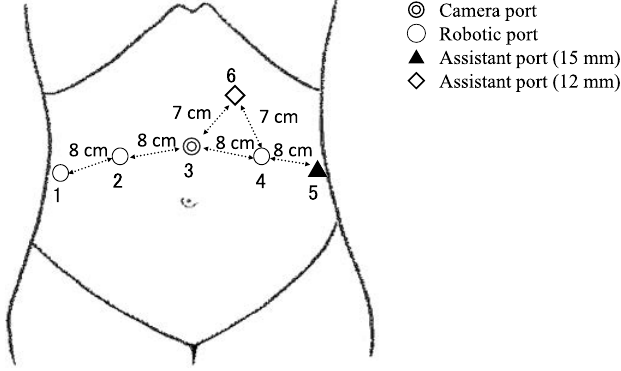
Figure 1 Port placement configuration. The camera port and three robotic ports were placed at positions 1, 2, 3, and 4. Additionally, 15-mm and 12-mm assistant ports were used at positions’ 5 and